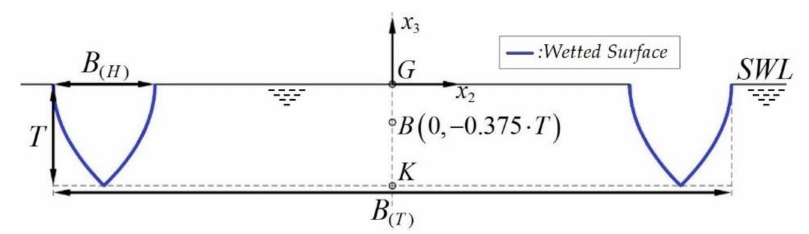
Figure 5. Outline of the modeled configuration and basic dimensions.